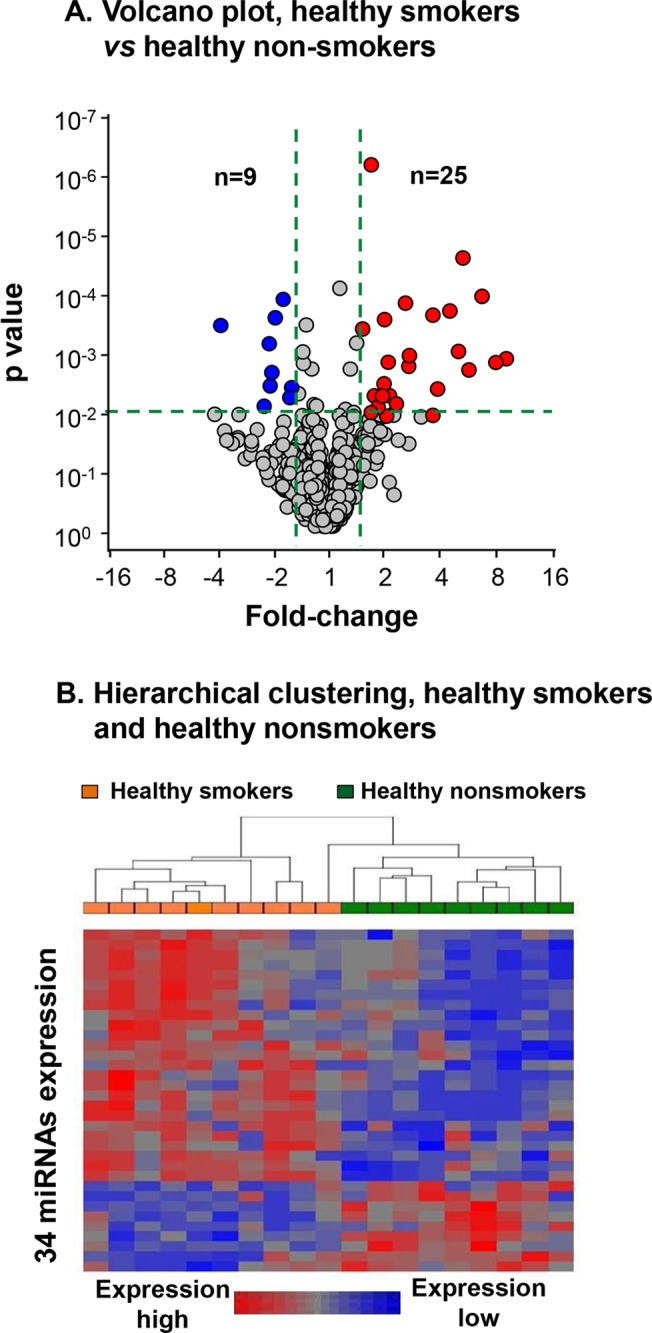
Volcano plot and unsupervised hierarchical clustering of differentially expressed miRNAs in the small airway epithelium (SAE) of healthy smokers and healthy nonsmokers.A. Volcano plot comparing the expression of 1100 human mature miRNAs in the SAE of smokers vs nonsmokers. There were 25 miRNAs (red) upregulated and 9 miRNAs (blue) downregulated in the SAE of healthy smokers compared to healthy nonsmokers (fold-change >1.5, p<0.01, total 34 miRNAs). X-axis, fold-change; Y-axis, p values. B. Unsupervised hierarchical clustering of 34 differentially expressed miRNAs between healthy smokers (tan rectangle) and healthy nonsmokers (green rectangle). The color bar indicates the relative miRNA expression level.